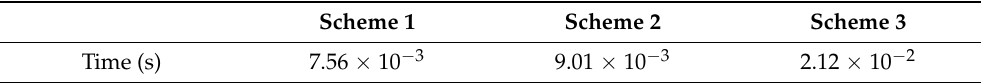
Table 3. The time required for the single-step execution of the three